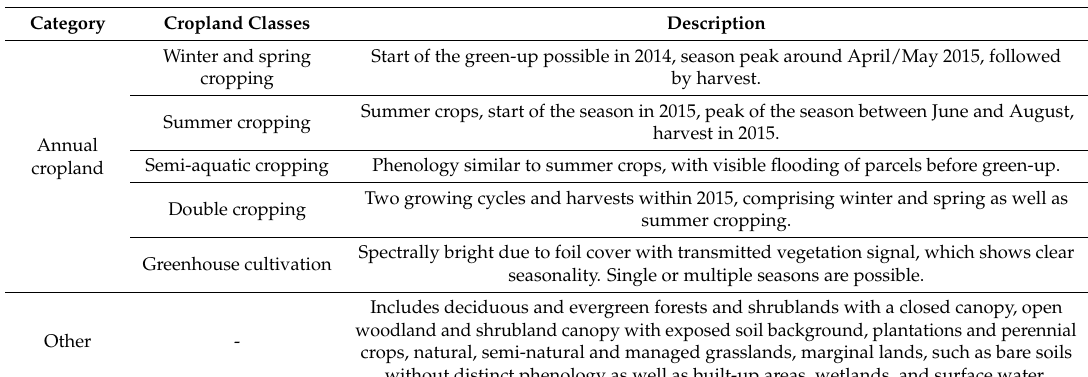
Table 1. Description of the class